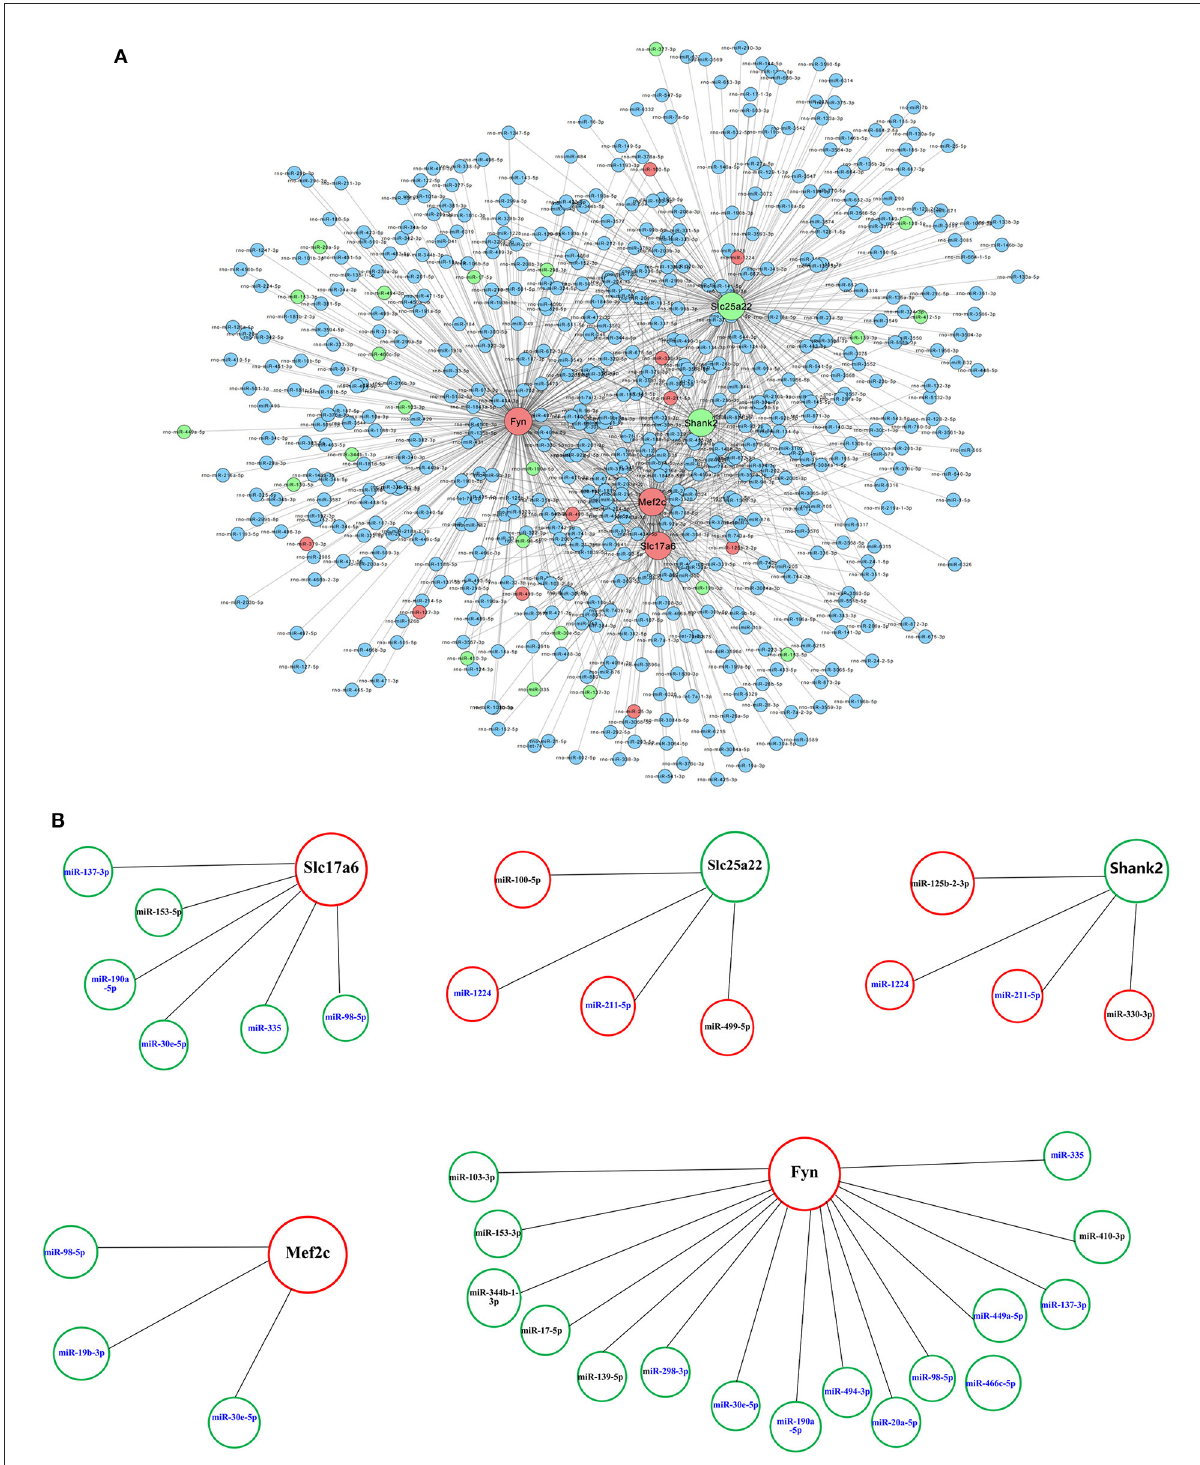
FIGURE4 Prediction of microRNA–mRNA interaction. (A) Interaction network of microRNAs with 8 glutamatergic-related mRNAs. (B) Interaction network of 31 microRNAs with five glutamatergic-related mRNAs. Larger dots indicate mRNAs. Smaller dots indicated microRNAs. Red indicates upregulated mRNAs or microRNAs. Green indicated downregulated mRNAs or microRNAs. Blue indicates unchanged mRNAs or